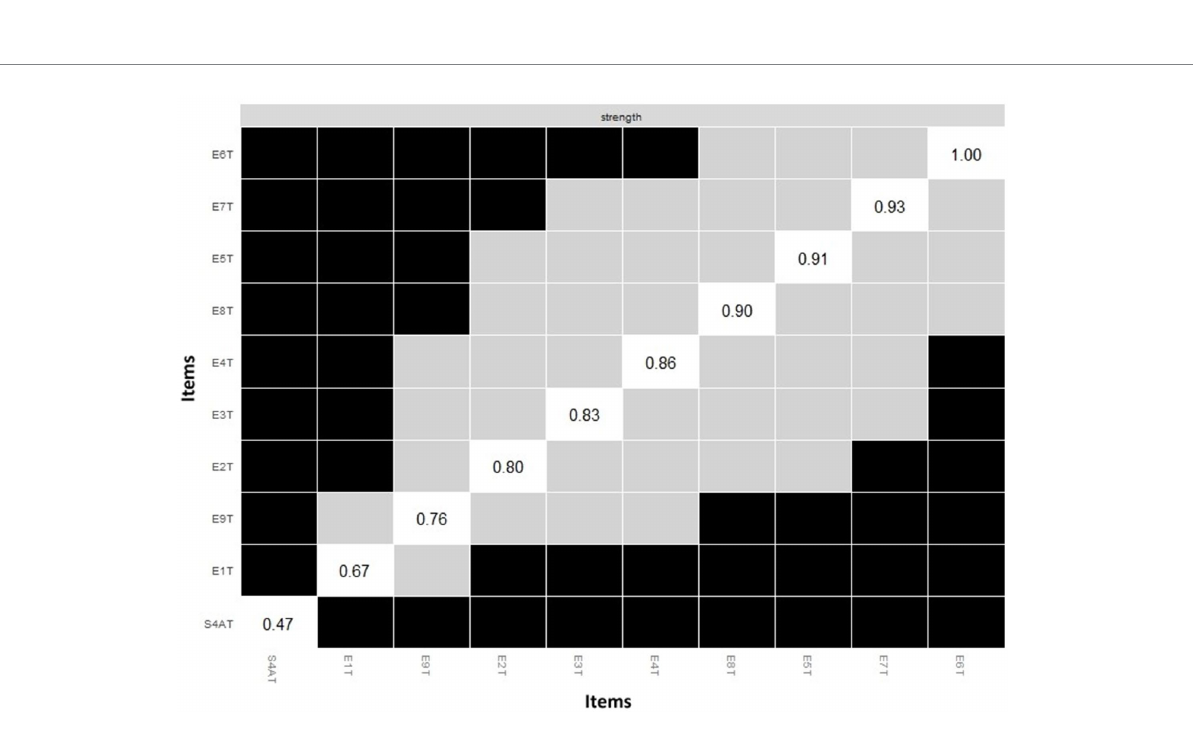
FIGURE 6 Bootstrap difference test for the strength of nodes. Bootstrap difference test for node strength is evident, where gray boxes indicate non- significant differences and black boxes indicate significant differences. T1: type 1; T2: type 2; T3: type 3; T4: type 4; T5: type 5; T6: type 6; T7: type 7; T8: type 8; T9: type 9; S4AT: healthy personality to psychosocial